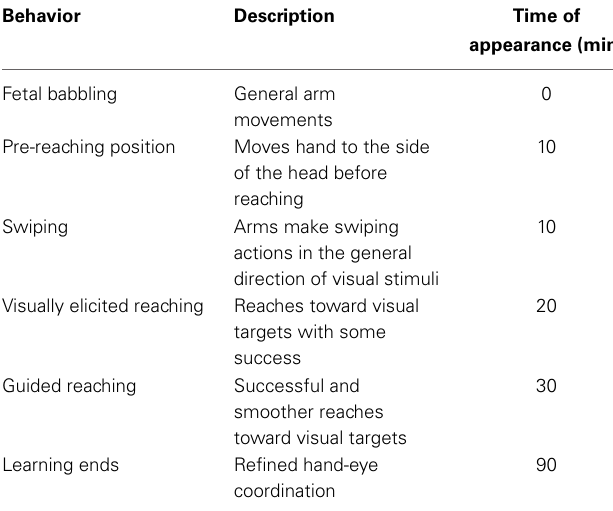
Table 7 | Behaviors observed in